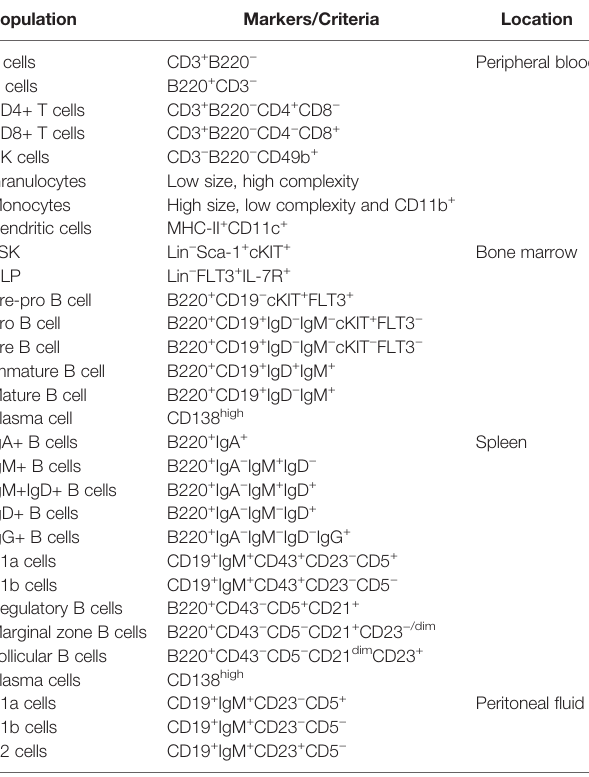
TABLE 3 | Flow cytometry patterns used to de fi ne murine immune populations. Population Markers/Criteria